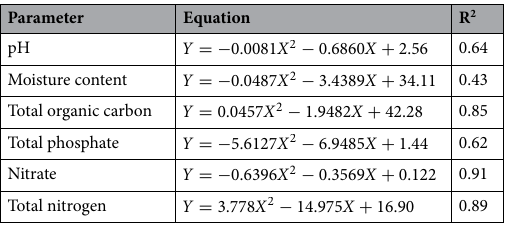
Table 2. Regression between indices of physico-chemical characteristics of goat manure